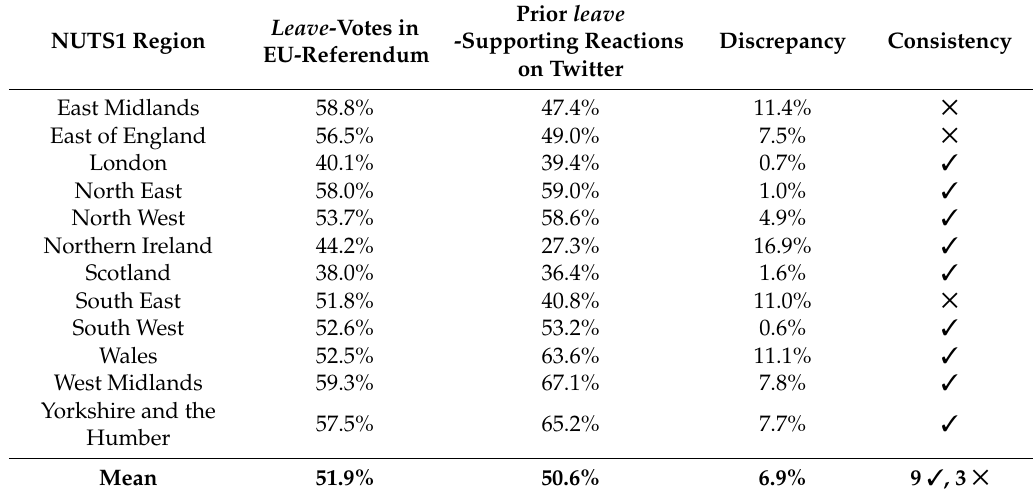
Table 4. Comparison of the referendum results and prior reactions on